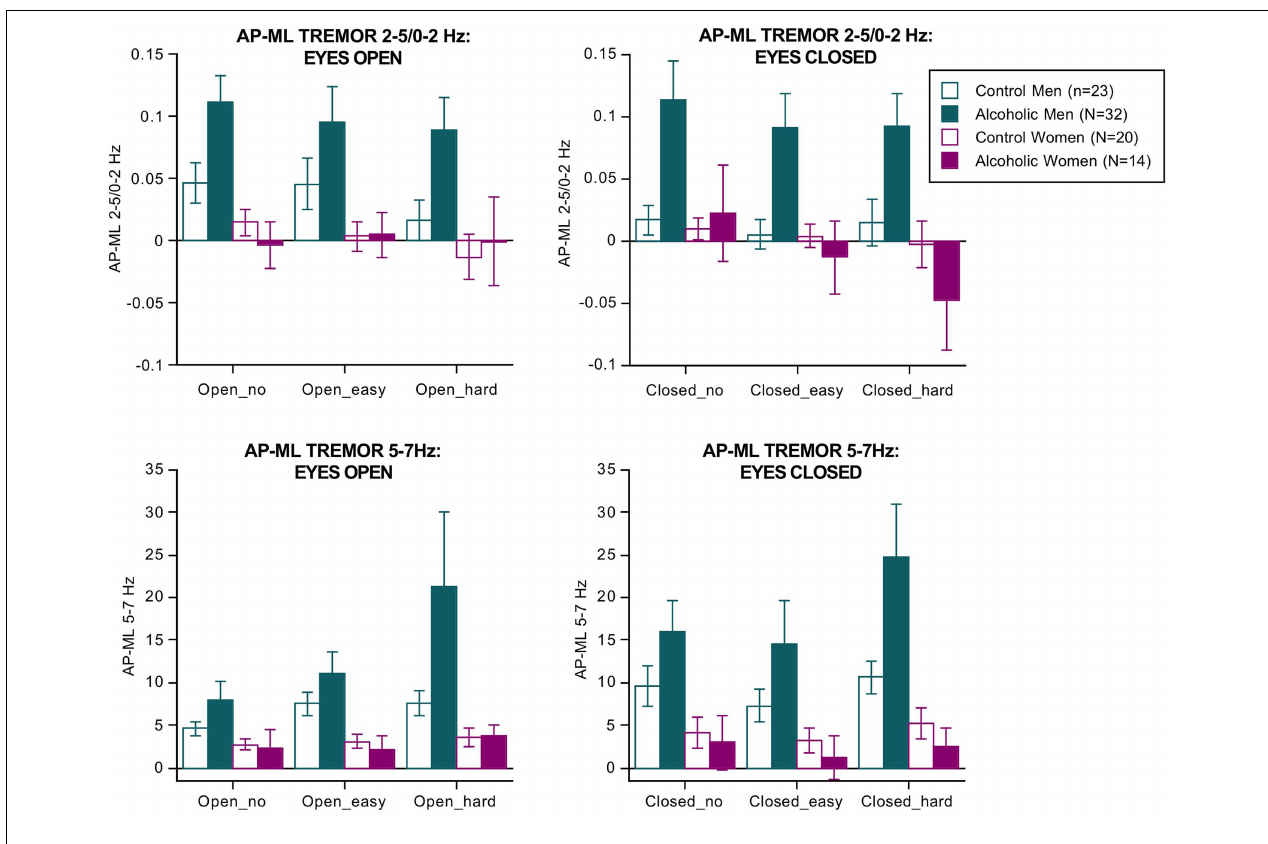
velocity in each group. Tremor was greatest in the alcoholic men; 5–7Hz tremor velocity showed a step-wise increase with increasing difficulty of the dual